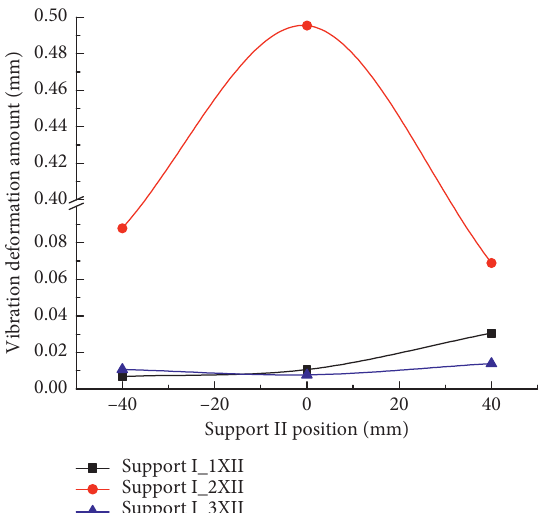
Figure 6: Comparison between the vibration deformation of the measured position at the next critical speed and the maximum vibration deformation on the shaft in the simulation.